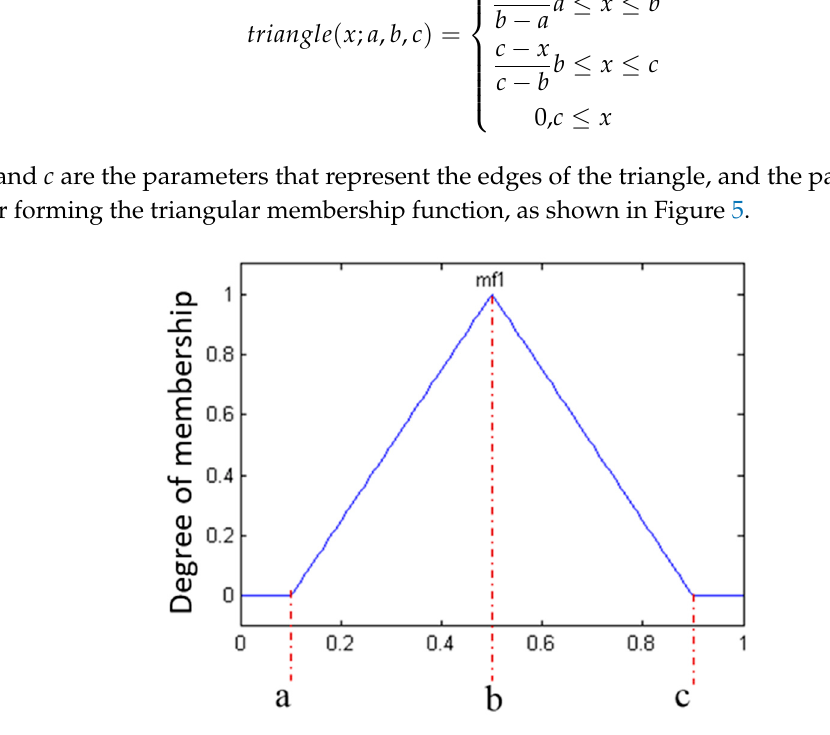
Figure 5. T1 triangular membership function.